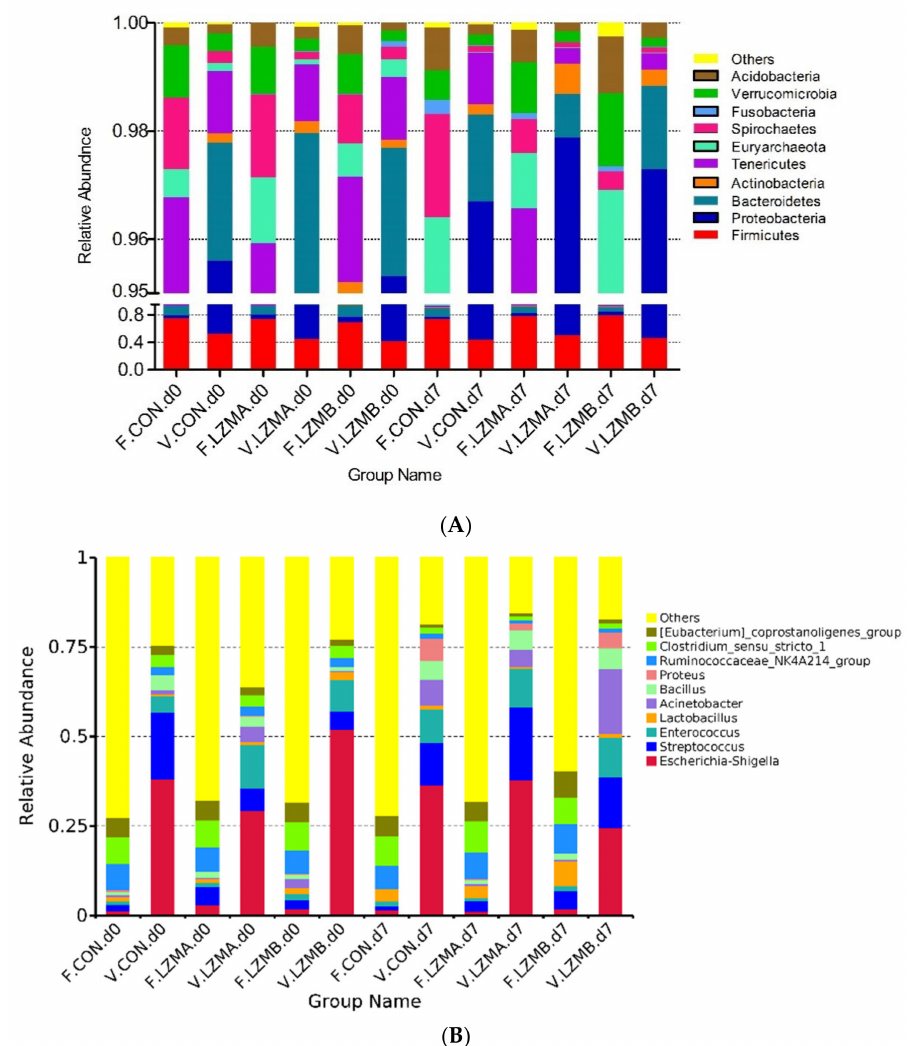
Figure 5. 16S rRNA gene analysis reveals phyla ( A ) and genus ( B ) level differences between vaginal and rectum microbiota, and the treatments. F. = sample from fecal, V. = sample from vagina, CON.d0 = control diet at the day of farrowing, CON.d7 = control diet at day 7 of lactation, LZMA d0 = control diet + lysozyme 150 mg/kg at the day of farrowing, LZMA d7 = control diet + lysozyme 150 mg/kg at day 7 of lactation, LZMB d0 = control diet + lysozyme 300 mg/kg at the day of farrowing, LZMB d7 = control diet + lysozyme 300 mg/kg at day 7 of